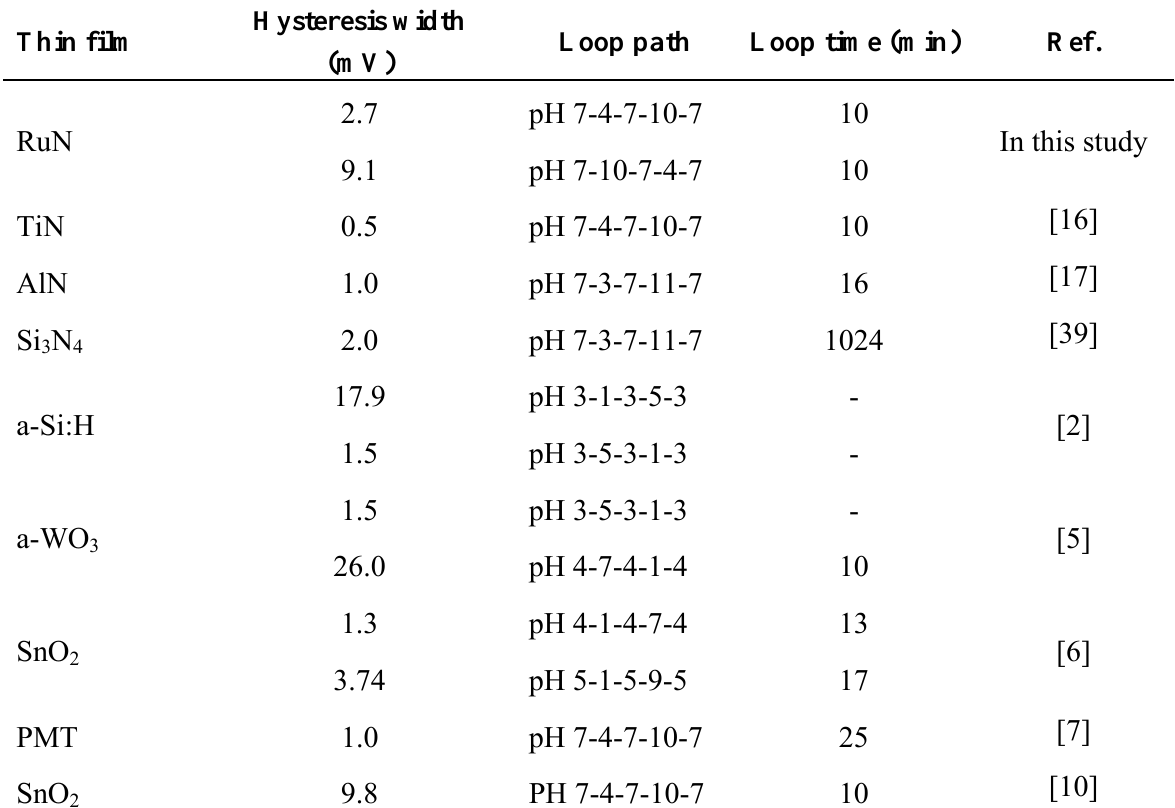
Table 4. Comparison of hysteresis widths for the different thin